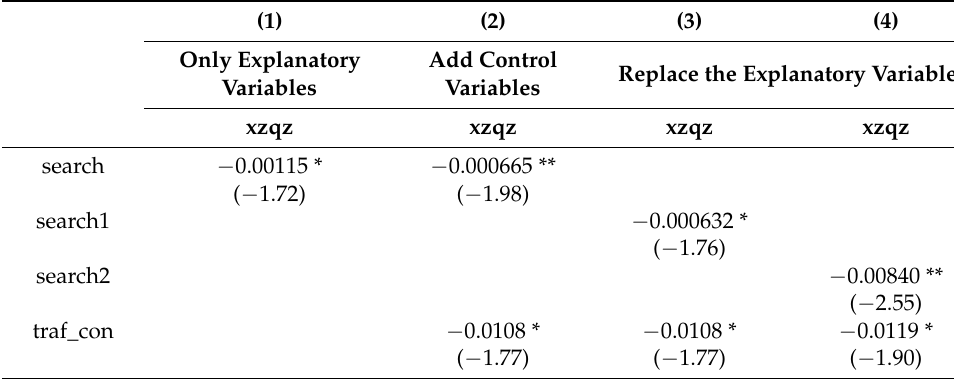
Table 6. Robustness test of new